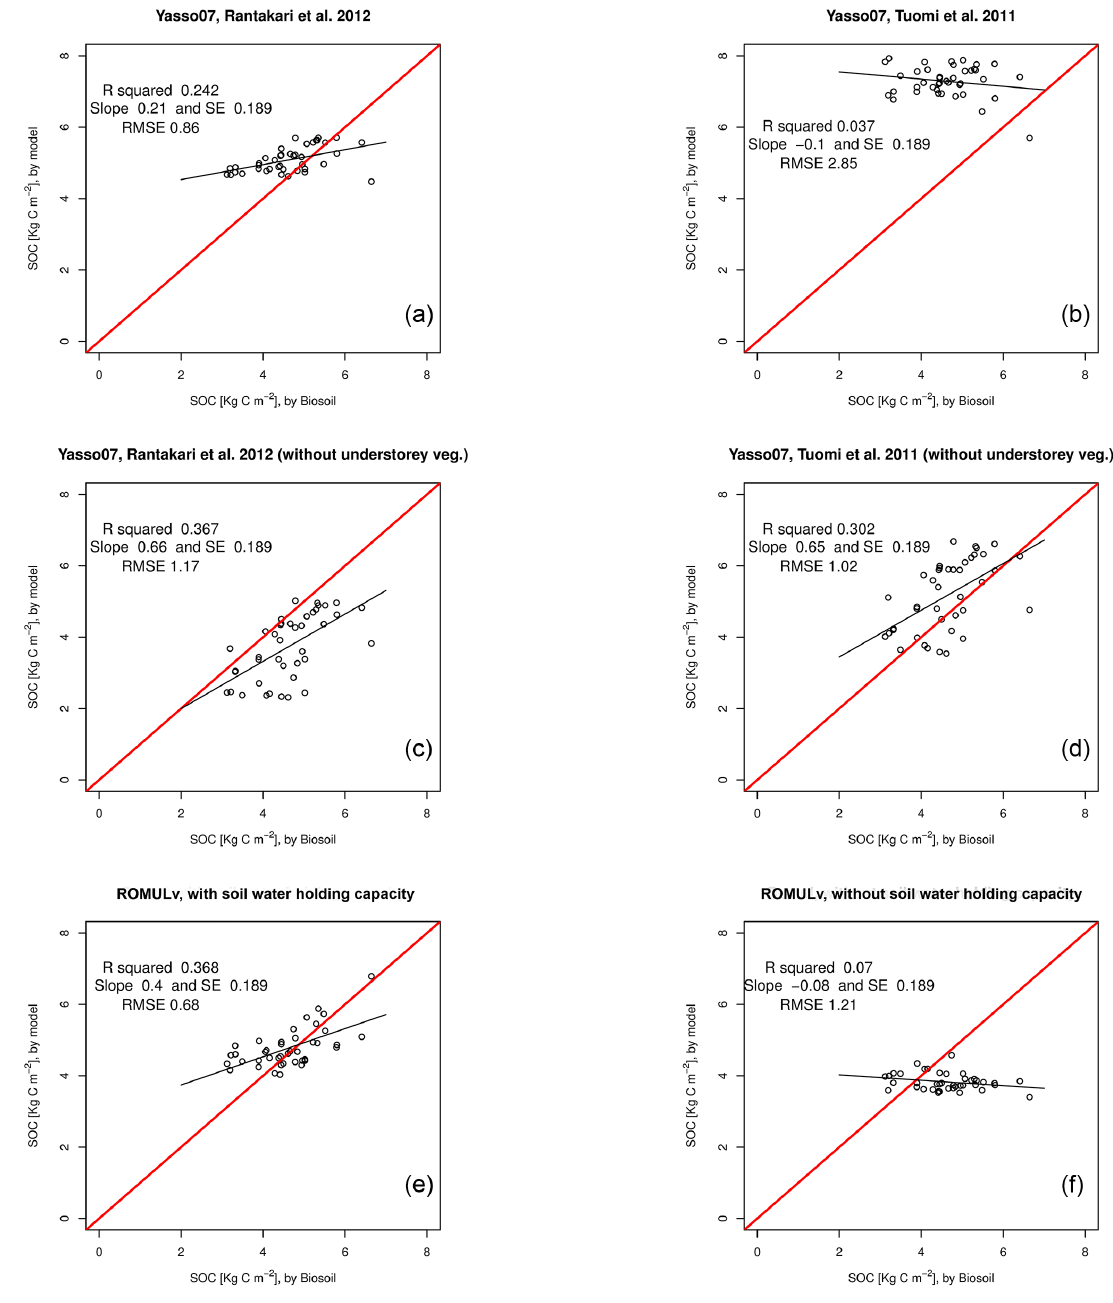
Figure 3. One-to-one plots for mean model estimates and mean Biosoil measurements of soil carbon stocks for 41 latitudinal bands across Finland. Panel (a) is Yasso07 with Rantakari et al. (2012) parameters, while panel (b) is with Tuomi et al. (2011) parameters. Panels (c) and (d) are same as panels (a) and (b) but without understorey litter input. Panels (e) and (f) show the ROMULv model where (e) is with soil water holding capacity data and (f) is with constant soil water holding capacity. R 2 , slope of the regression and the slope standard error are reported. RMSE is based on the difference between model estimate and